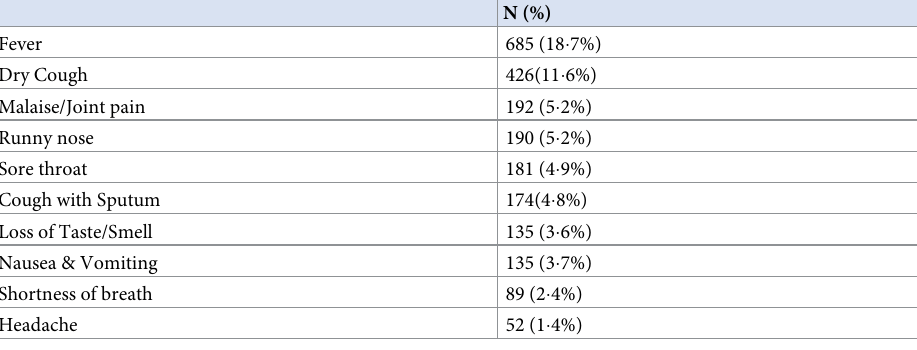
Table 2. Spectrum of symptoms of COVID-19 among cases during pregnancy.